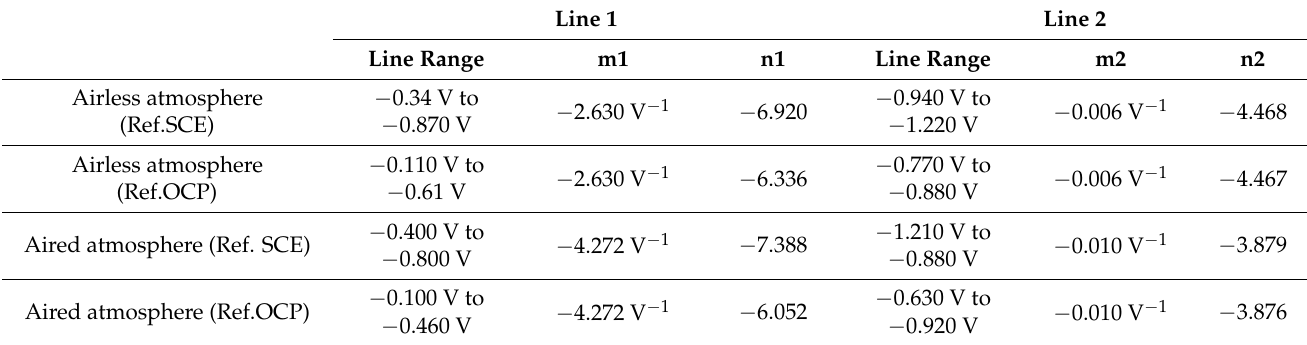
Table 5. Values of lines 1 and 2 defined in Figure 5b,c for the airless and aired atmospheres.